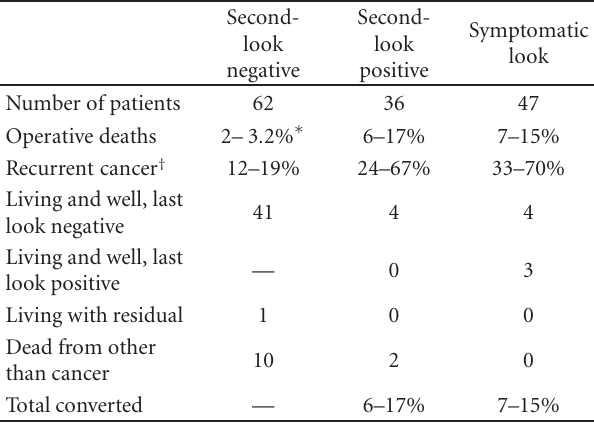
Table 1: Second-look surgery in patients with cancer of the colon (reprinted from [6] with